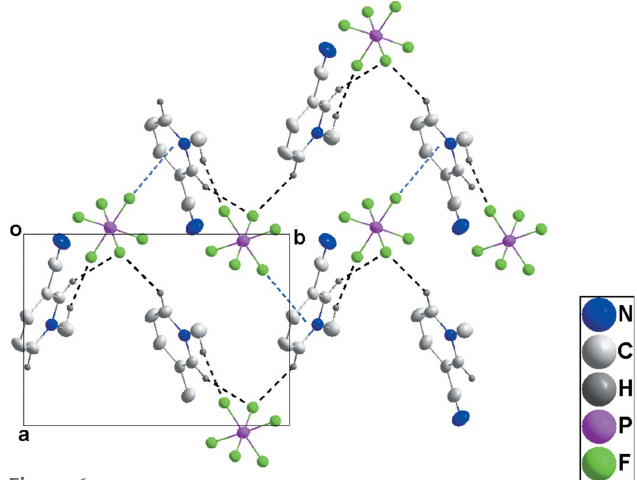
Figure 6 View of two adjacent cation–anion chains in 2 along the c -axis direction